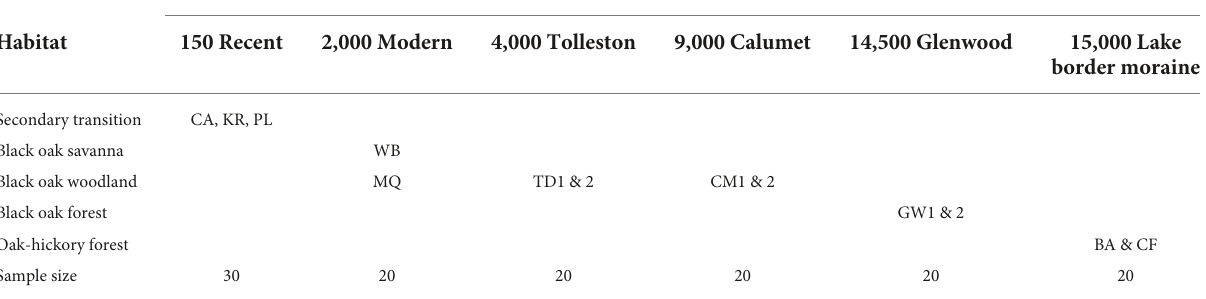
TABLE 2 Crosswalk between habitat and site age (ybp) for 13 sites sampled for rhizosphere bacteria, soil chemistry and